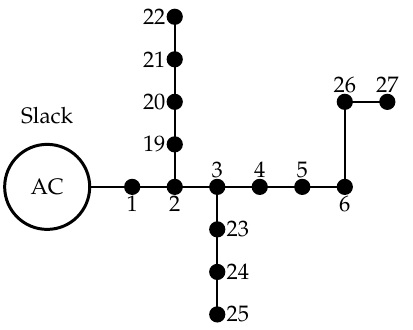
Figure 3. Nodal connections in the 15-bus test feeder.